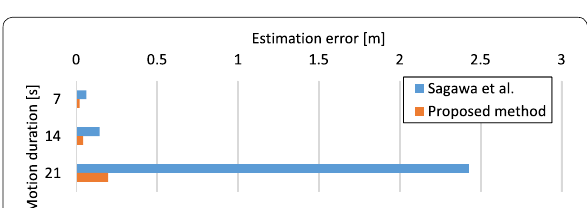
Fig. 12 Trajectory estimation results for long motions (real IMU